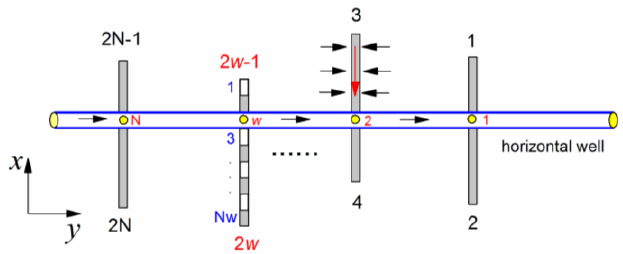
Figure 1. Schematic of multiple finite-conductivity fractures along a horizontal well.